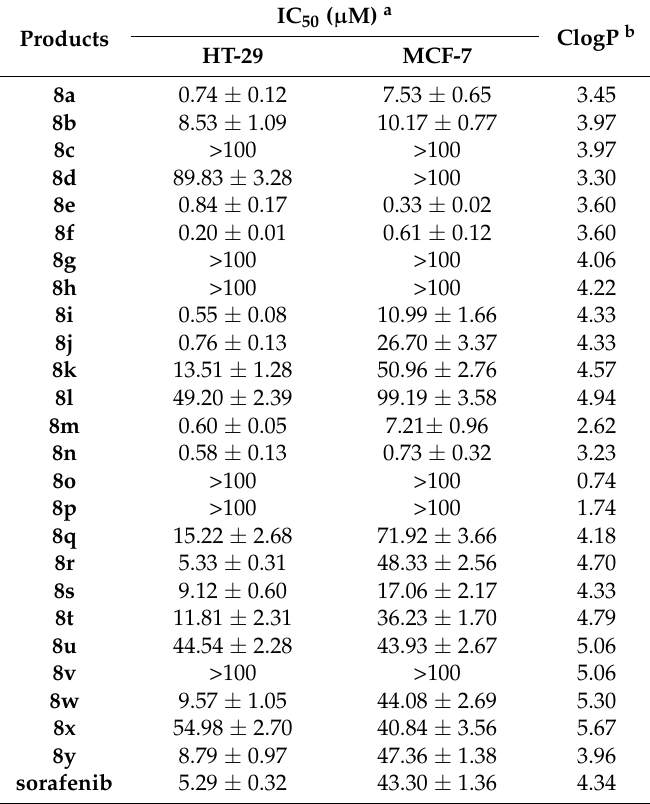
Table 1. Antiproliferative activities and calculated logP-values of compounds 8a – 8y